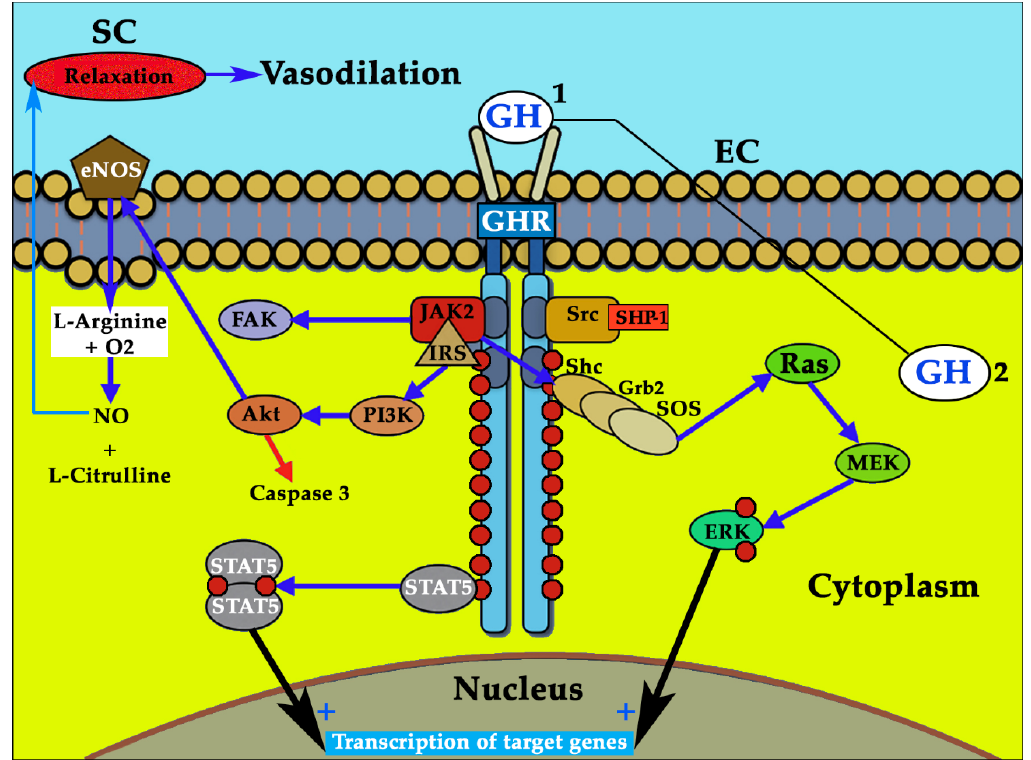
Figure 1. Effects of growth hormone (GH) on the vascular endothelium. The interaction GH–GHR (growth hormone receptor) produces the activation of the associated Janus kinase 2 (JAK2), which induces the phosphorylation (red circles) of tyrosine located in the cytoplasmic receptor domain, leading to the phosphorylation of GH-signaling pathways, such as signal transducers and activators of transcription (STATS). Among STATS (STATS 1 and 3 not shown in the Figure), STAT5 homodimerizes and is translocated to the nucleus, where it induces the transcription of a series of genes. Activated JAK2, acting on the insulin receptor substrate (IRS) induces the phosphorylation of phosphoinositide 3-kinase (PI3K) which, in turn, activates the cell survival factor serine-threonine kinase (Akt). This inhibits the proapoptotic enzyme Caspase 3 (red arrow), but it also activates endothelial nitric oxide synthase (eNOS) (blue arrow). Activated eNOS promotes the synthesis of nitric oxide (NO) (from L-Arginine and O2) and the formation of L-Citrulline. The formed NO flows from the cytoplasm to the muscle cell layer of the blood vessels, producing its relaxation and consequent vasodilation. The interaction GH–GHR also induces the activation of the Shc adapter proteins, which leads to the activation of the Grb2–SOS–Ras–Raf–MEK–ERK (extracellular signal-regulated kinase) pathway (Raf is not shown in the figure). Activated ERK translocates into the nucleus of the endothelial cells (ECs) and regulates the expression of genes involved in cell proliferation, differentiation, and survival, but it also regulates cell motility and migration (key for the formation of new vessels). The GH–GHR interaction also activates focal adhesion kinase (FAK). SHP: protein tyrosine phosphatase. Blue arrows: stimulation. Red arrow: inhibition. Black arrows: Translocation to the nucleus. 1: endocrine GH. 2: endothelial GH: plays and auto/paracrine role and in situations of the absence of endocrine GH perhaps plays the role of the former (black line).